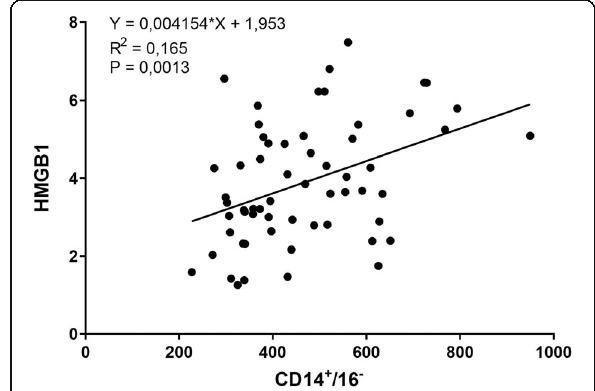
Fig. 13 Correlation between plasma HMGB1 with circulating CD14 + CD16 − monocytes during 3 weeks of exercise. HMGB1 showing a positive correlation with CD14 + CD16 − cell